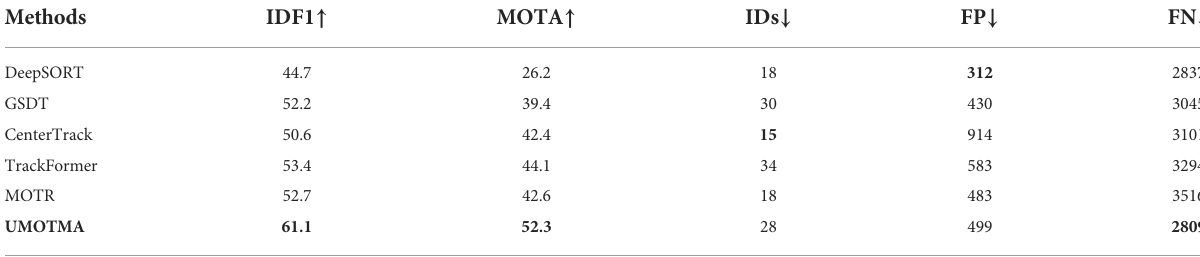
TABLE 1 Comparison of the methods on the UMOT test